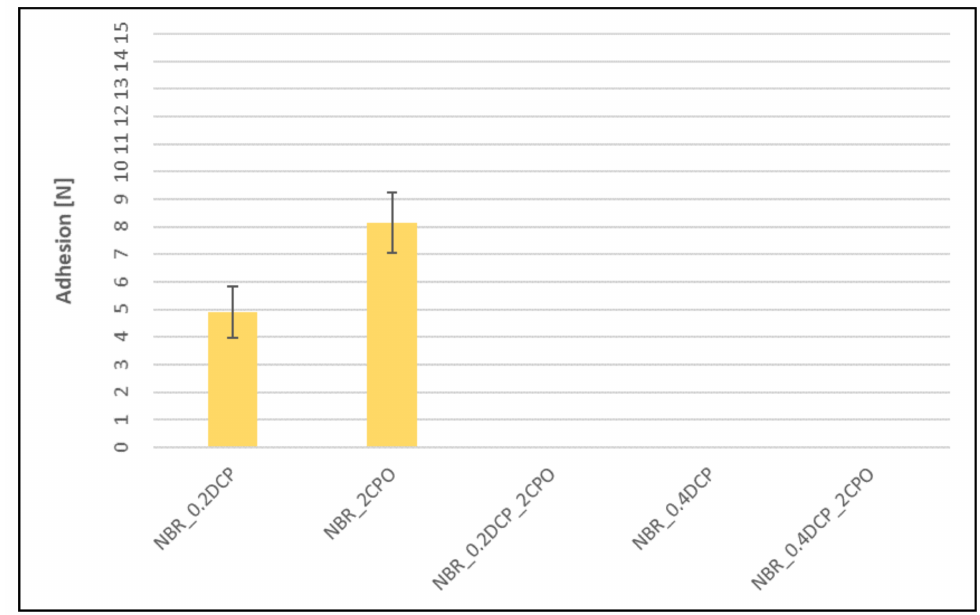
Figure 8. Influence of the peroxide curing system modification on adhesion between peroxide NBR vulcanizates and silver wires (missing bars indicate the lack of adhesion).